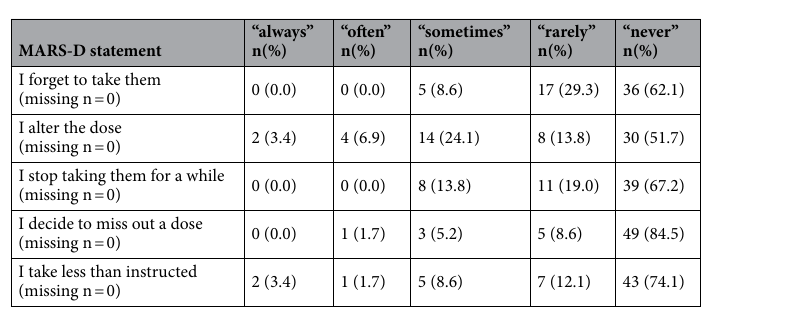
Table 2. Distribution of the response frequencies of the Medication Adherence Report Scale (MARS-D) for patients with cluster headache (n = 58).